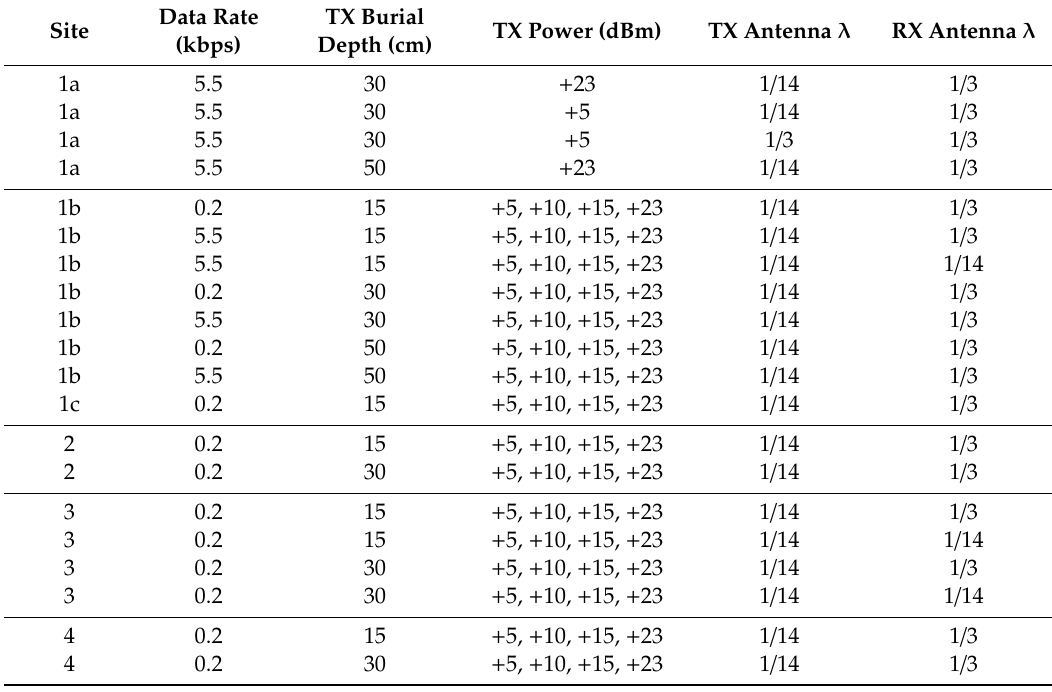
Table 2. Details of underground-to-aboveground (UG2AG) trials.